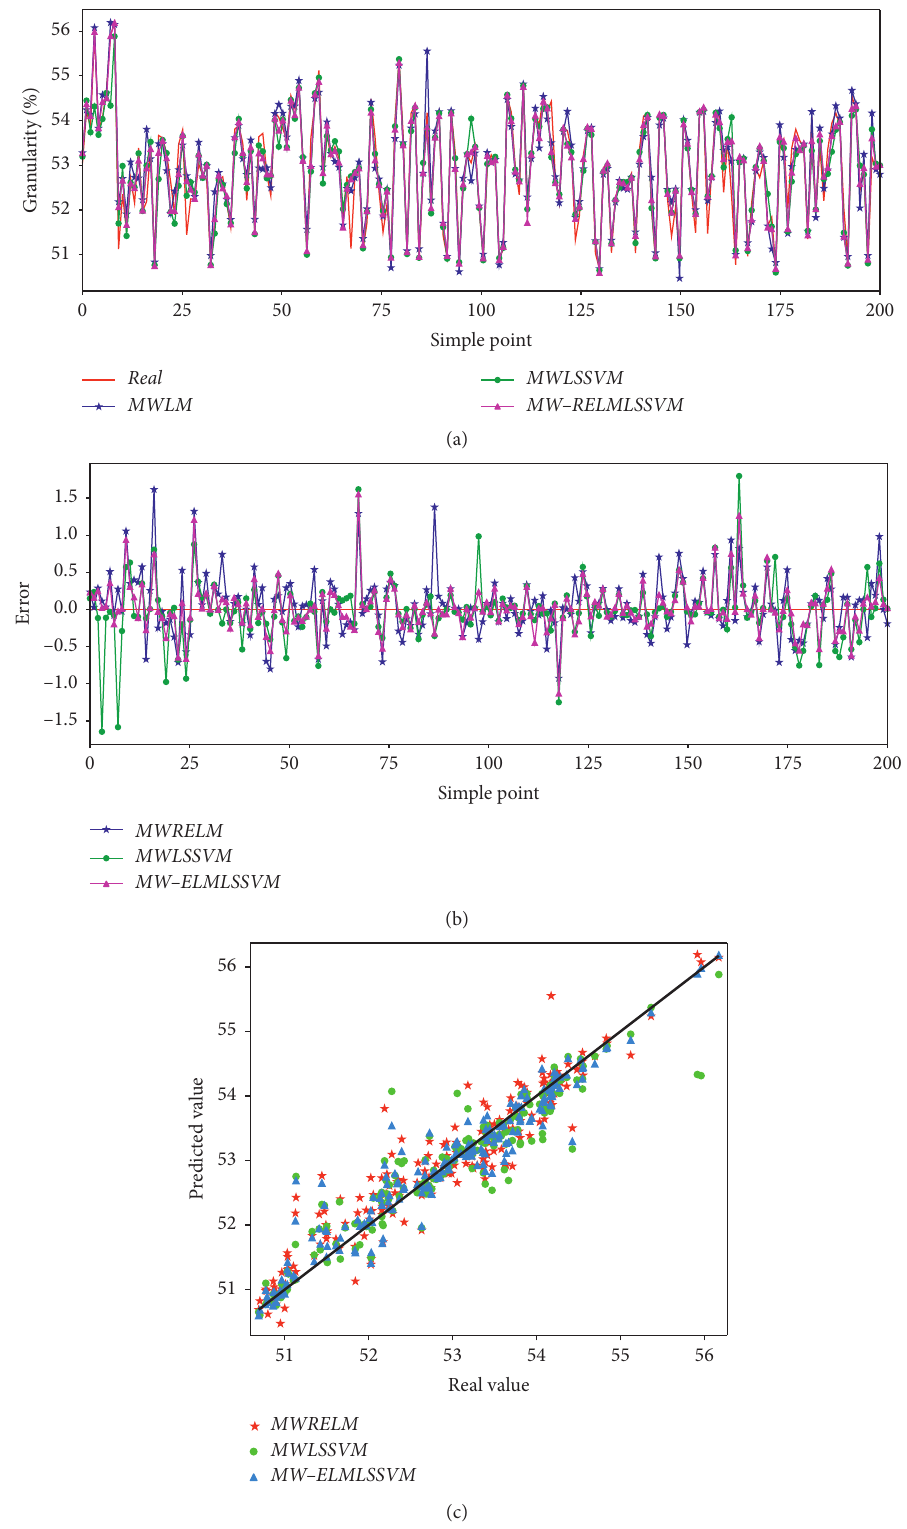
Figure 15: Experimental results under different hybrid models. (a) Prediction results under different soft-sensor models. (b) Prediction errors under different soft-sensor models. (c) Predicted scatter plots under different soft-sensor